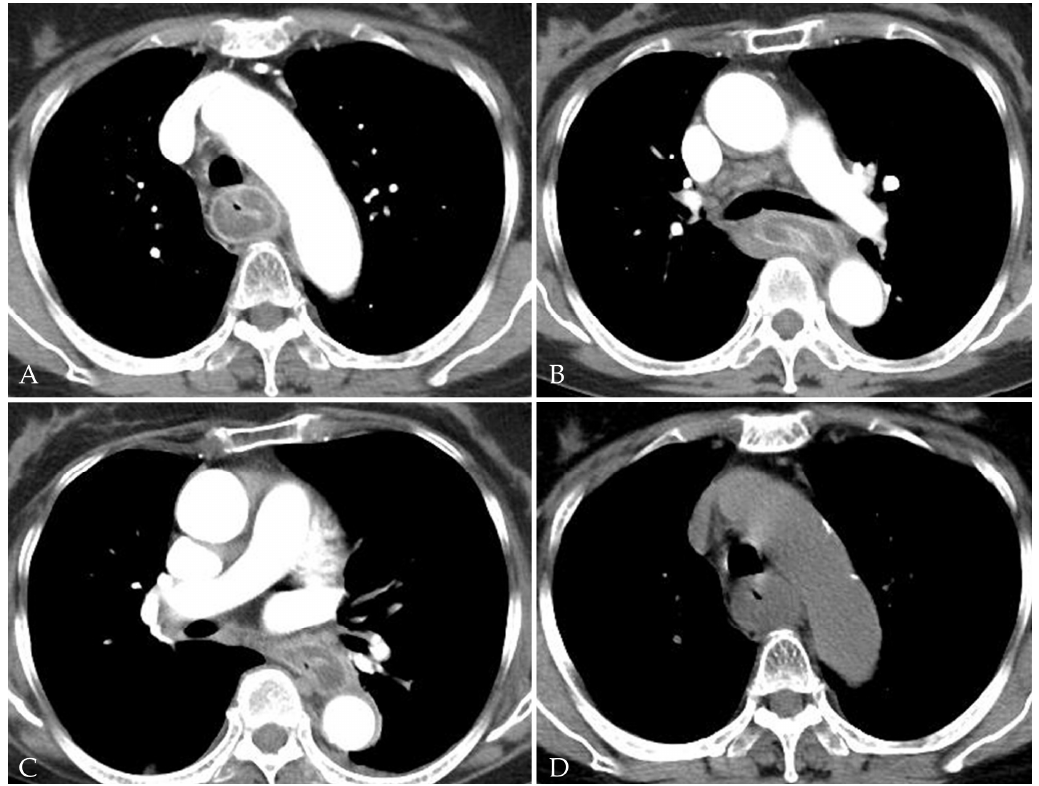
Figure 4. A 76-year-old woman with acute phlegmonous esophagitis. Axial contrast-enhanced CT images ( A – C ) show diffuse circumferential esophageal wall thickening with esophageal wall rim enhancement and an internal hypodense lesion, which was hypodense on pre-contrast-enhanced CT image ( D ).